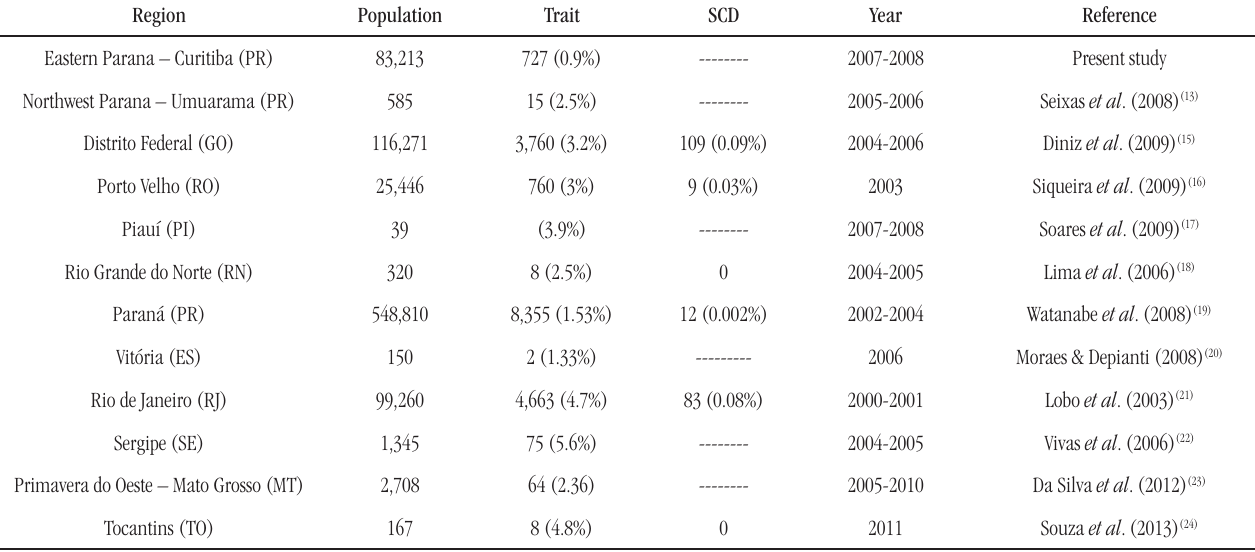
taBLE − Prevalence of sickle cell trait and SCD in different Brazilian